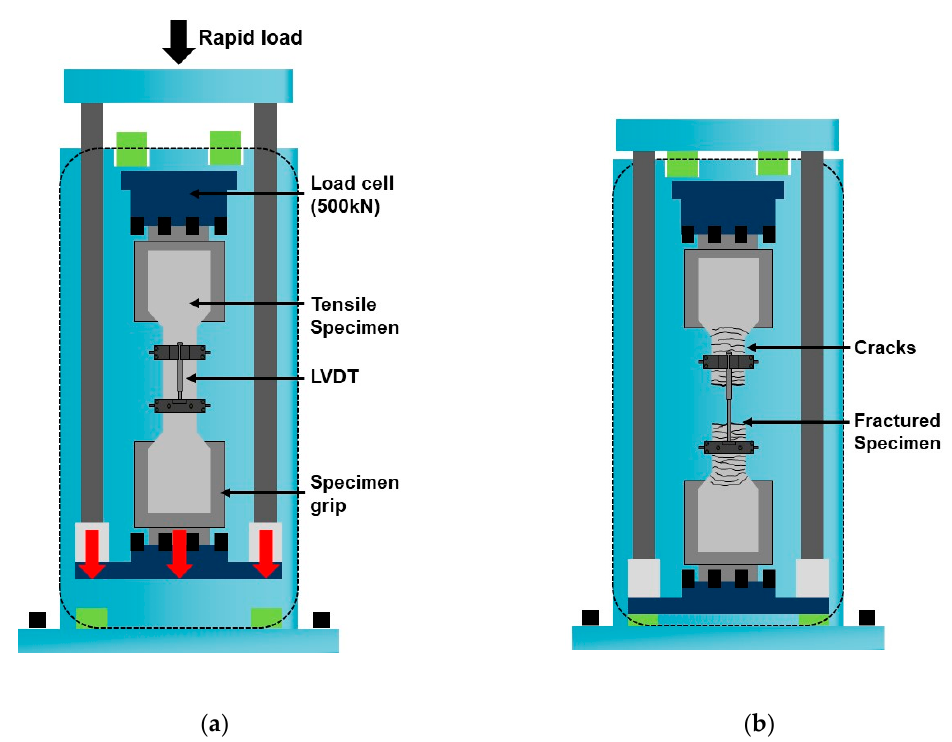
Figure 3. High-rate tensile test equipment.